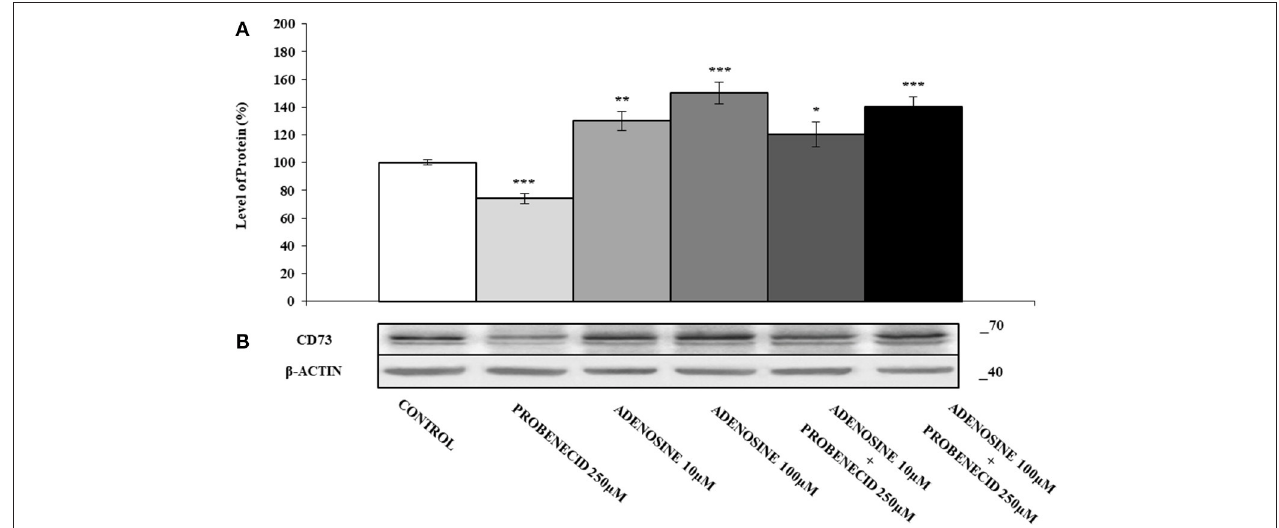
FIGURE 2 | The effects of adenosine on CD73 protein expression, with or without Probenecid. (A,B) Densitometric analysis and representative western blot of CD73 in three independent experiments (means ± SD). * p < 0.05, ** p < 0.01, *** p < 0.001, Student’s t -test. β -actin was used as a loading control. All the experiments were performed treating HepG2 cells with adenosine and/or Probenecid for 48h. DMSO-treated cells were used as control.